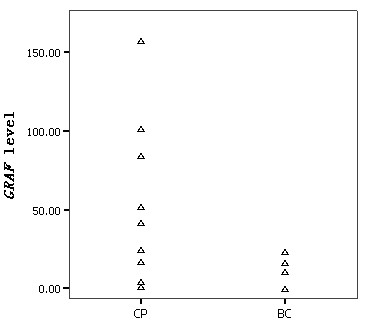
Expression level of GRAF transcript in CML.